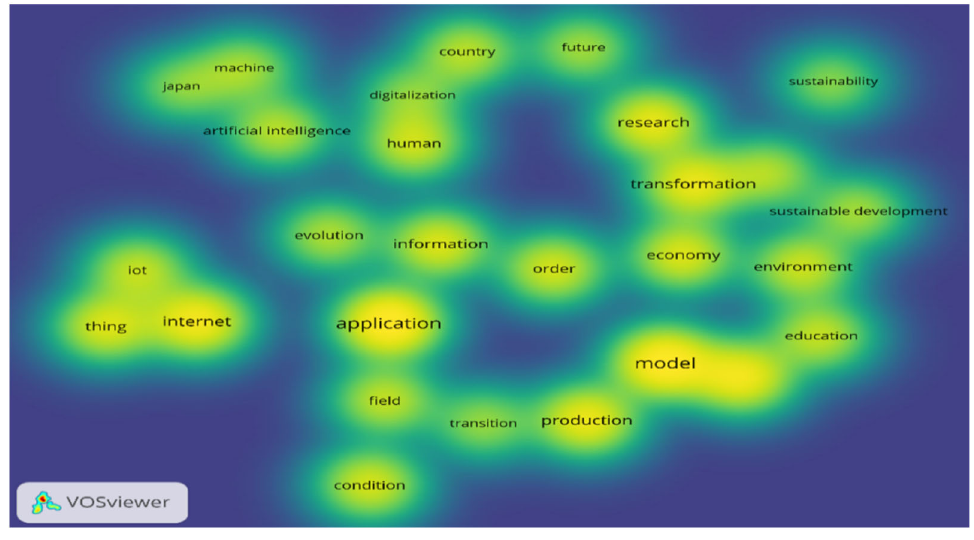
Figure 3. The density visualization of the scientific literacy topic areas.